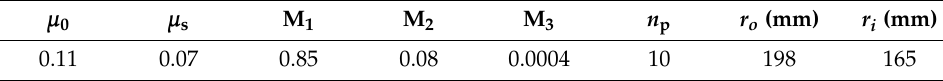
Table 4. Equivalent moment of inertia used in the simulation (kg·m 2 ). Table 5. Clutch parameters used in the simulation.